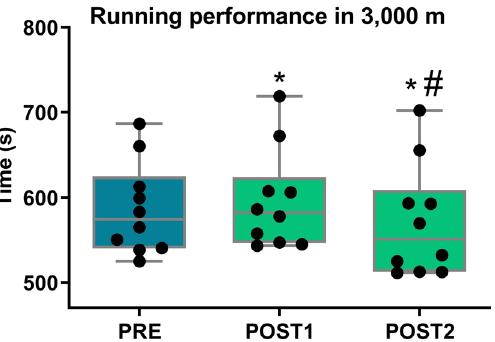
Figure 4. Running performance in 3000 m before (blue bar) and at two moments after altitude exposure (green bar). Box plots depict median value (line in the box) with box edges representing 25th–75th percentiles and whiskers showing range of values (min to max). *Difference of PRE, # difference of POST1 (according to repeated ‐ measures ANOVA using the Newman–Keuls post-hoc